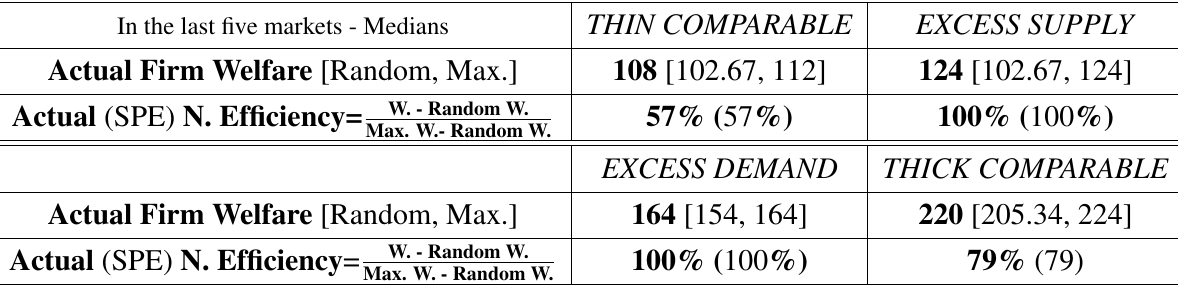
Table 4. Median of the sum of firm payoffs in the last five markets, with random match payoffs and maximum firm payoffs under full matchings in parentheses, and normalized efficiency, with the theoretical SPE prediction in